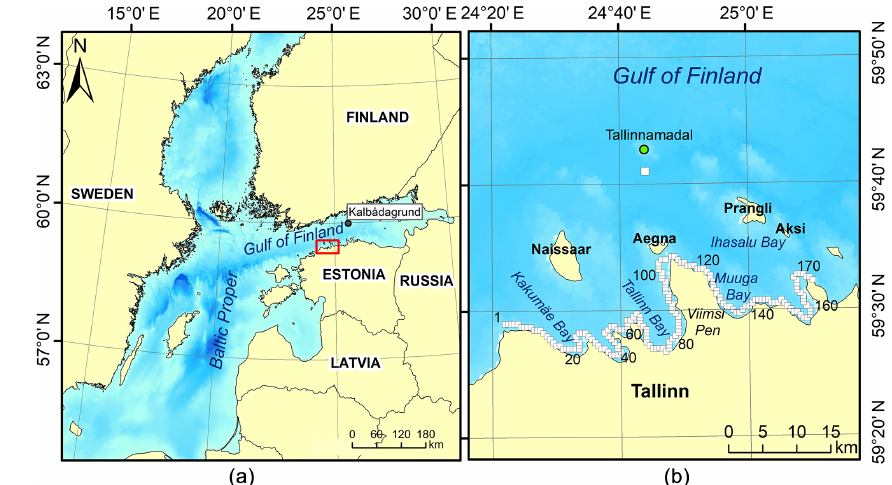
Figure 2. Study area (red box in a ) in the vicinity of Tallinn Bay. Small squares along the shoreline in (b) indicate the nearshore grid cells of the wave model WAM with a resolution of about 470m. The grid cells are numbered consecutively from the west to the east. The green circle shows the location of the wave buoy at Tallinnamadal, and the white square to the south of it is the closest grid point of the wave model used for comparison of modelled and measured wave data.